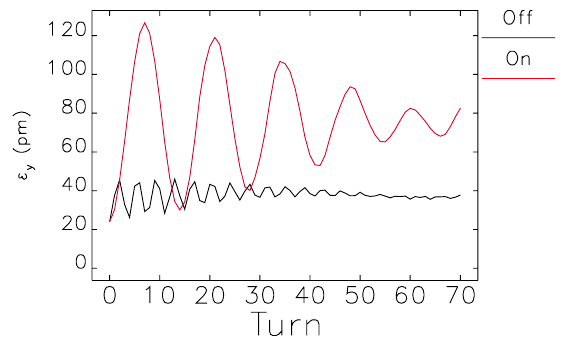
10. (Color) Vertical emittance on subsequent turns for V (cid:3) 2 MV and h (cid:3) 8 , with interior sextupoles on and off, without synchrotron radiation